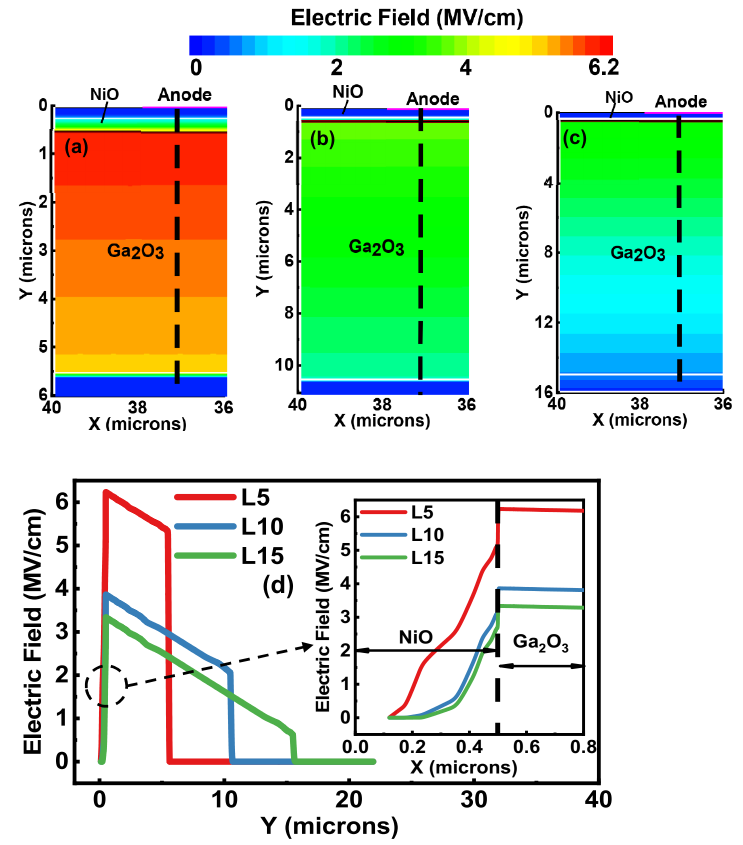
Figure 4. 2D electrical field distribution in HJ ‐ PN diode with ( a ) 5 μ m, ( b ) 10 μ m, and ( c ) 15 μ m drift layer thicknesses at a reverse bias of 3000 V. ( d ) Electrical field versus position for HJ ‐ PN with 5 μ m, 10 μ m, and 15 μ m drift layer thicknesses at − 3000 V along the cutlines shown in the contour plots.